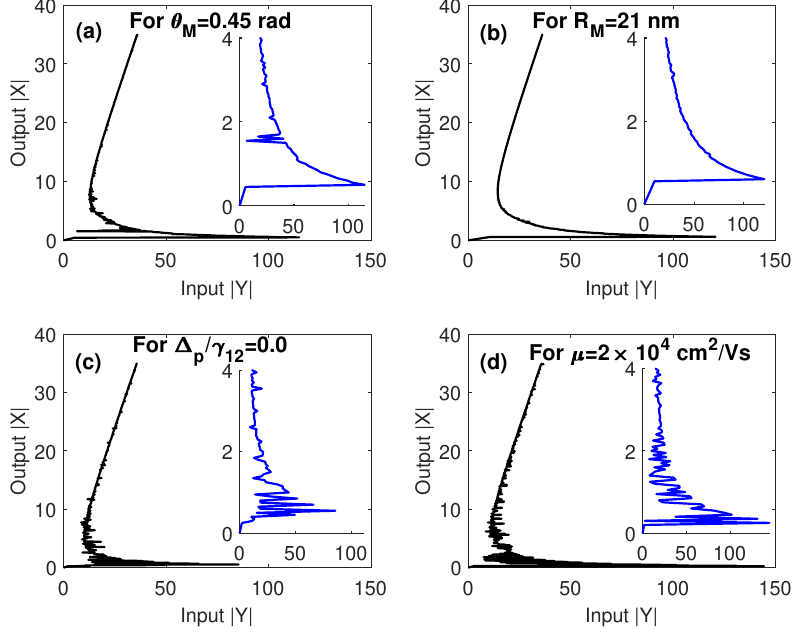
Ω = 0.5, and γ 32 = 1. The other parameters c γ 12 γ 12 = 0.4 rad, θ = 1 rad and C = 121.36, and the mobility M G